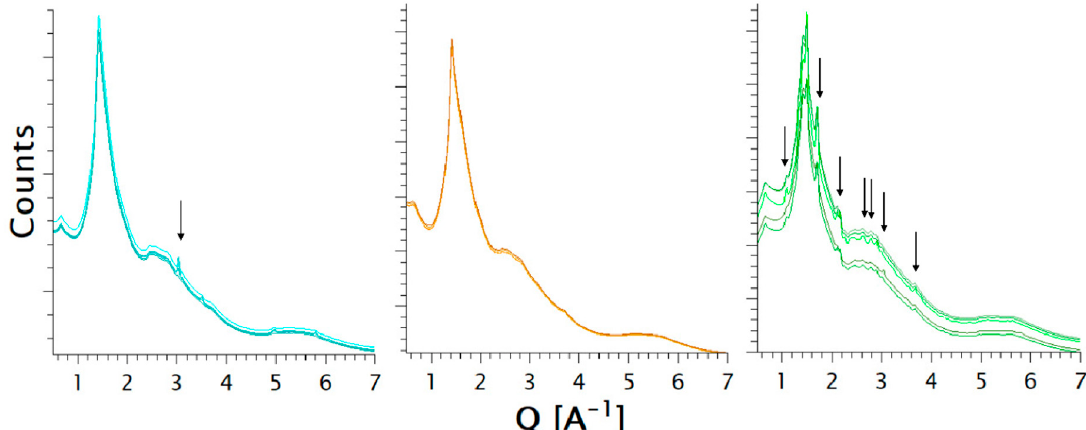
Figure 2. X-ray synchrotron results (i.e., arbitrary counts versus Q vector, Q = 4 π sin( θ )/ λ ) are displayed from the extrudates with amino acid coformers. The amino acids added to NaCMC are from left to right: arginine (cyan), lysine (orange), and histidine (green). Each diffraction pattern corresponds to a measured area in the extrudate.